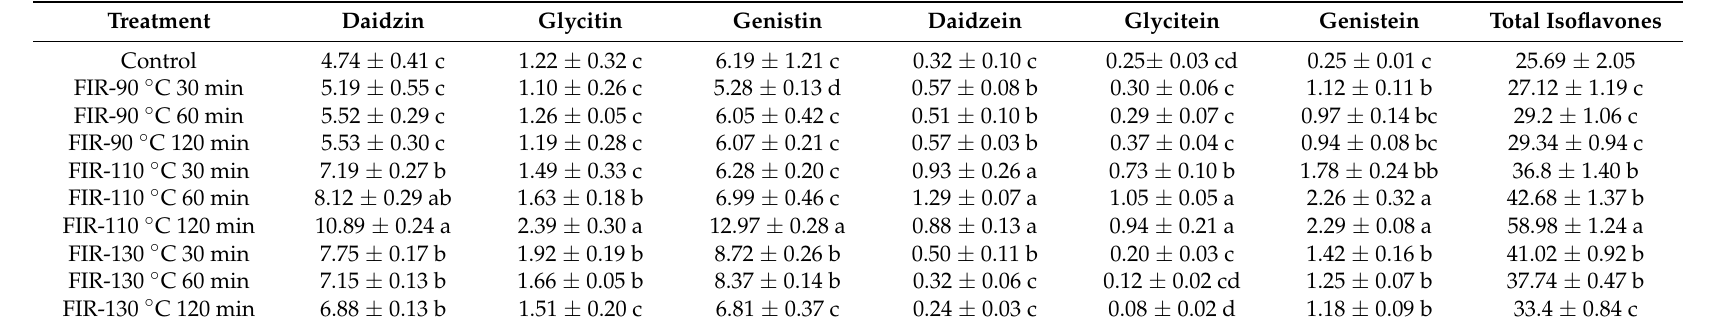
The values are mean ± SD. ( n = 3). Values labeled with different letters are significantly different ( p <